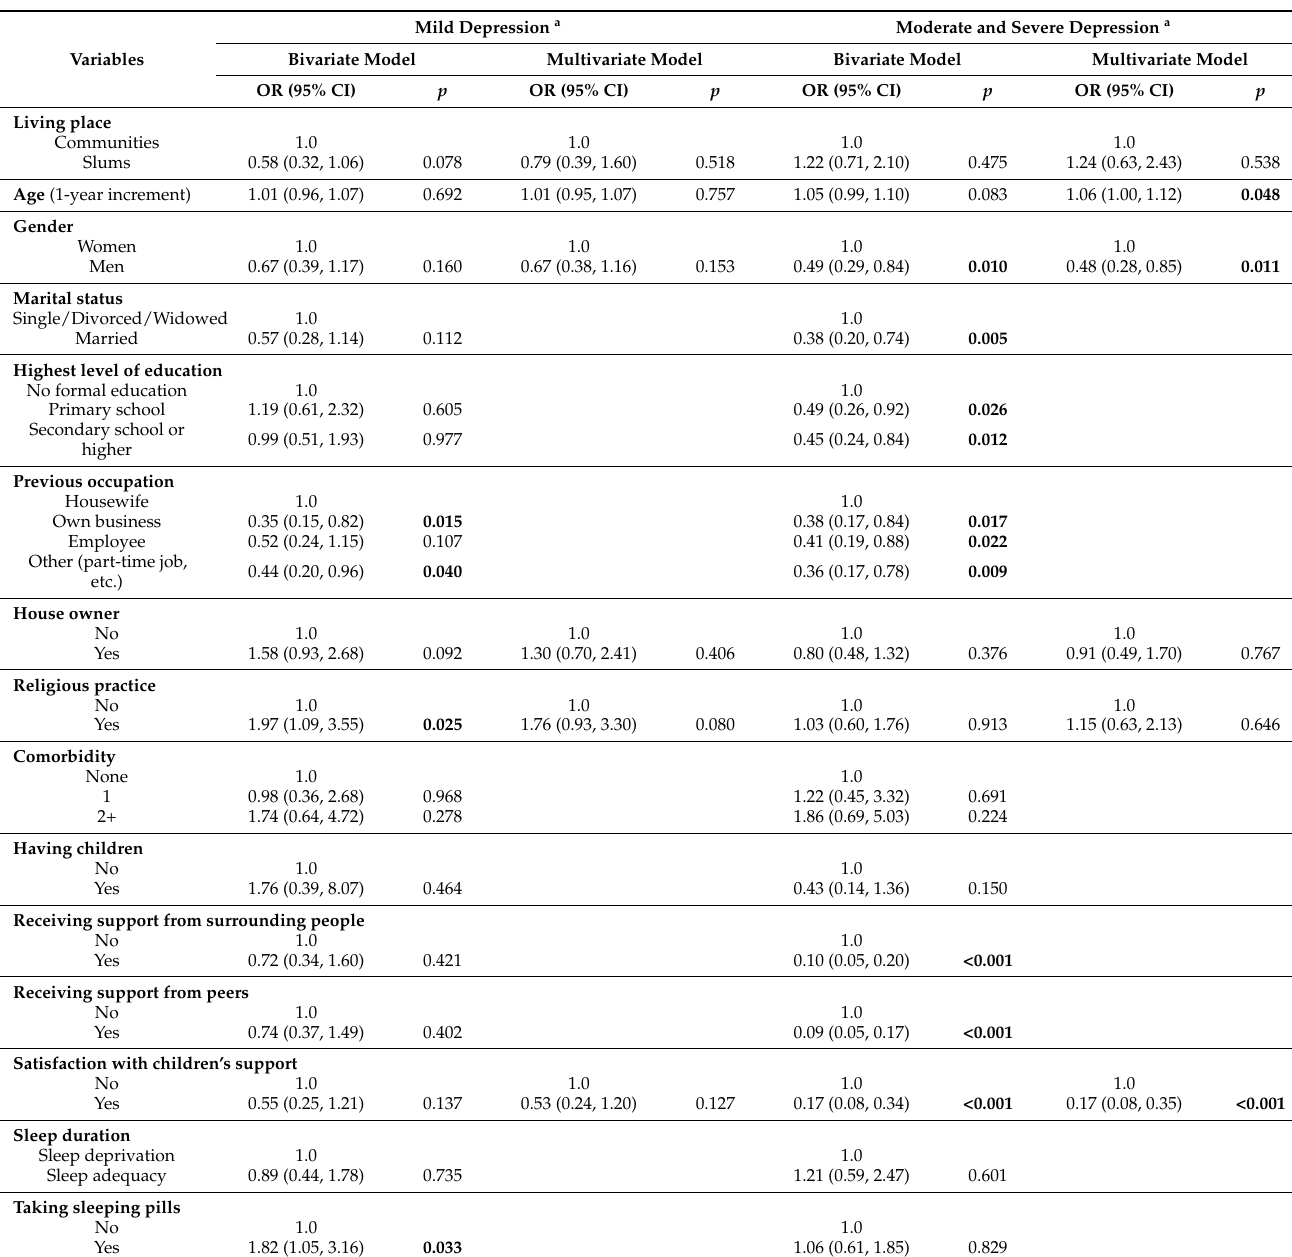
Table 4. Results of the simple and multiple ordinal logistic regression analyses predicting depression (n =